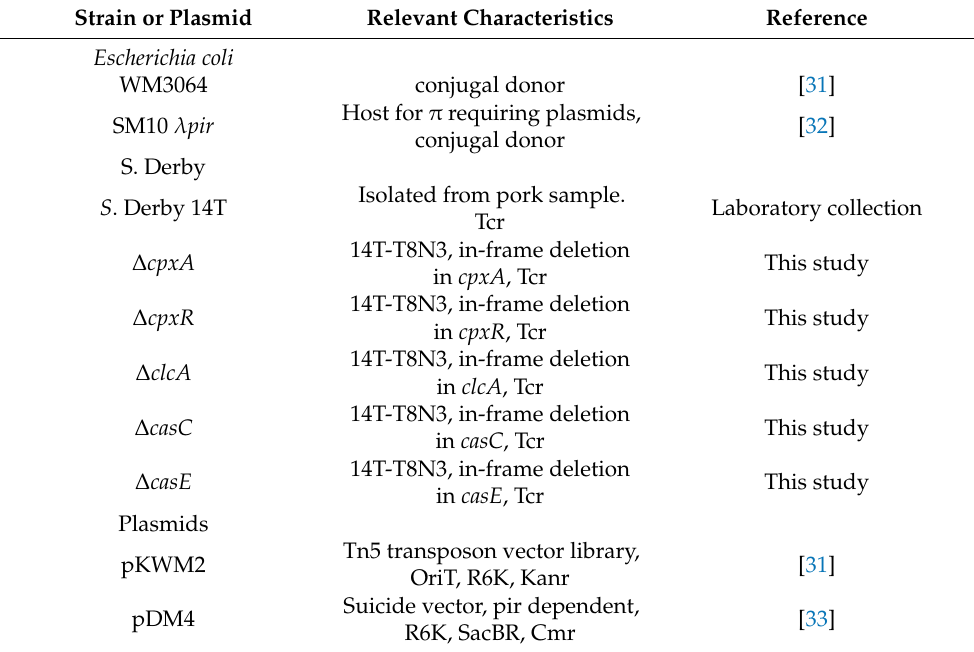
Table 1. Bacterial strains and plasmids used in this